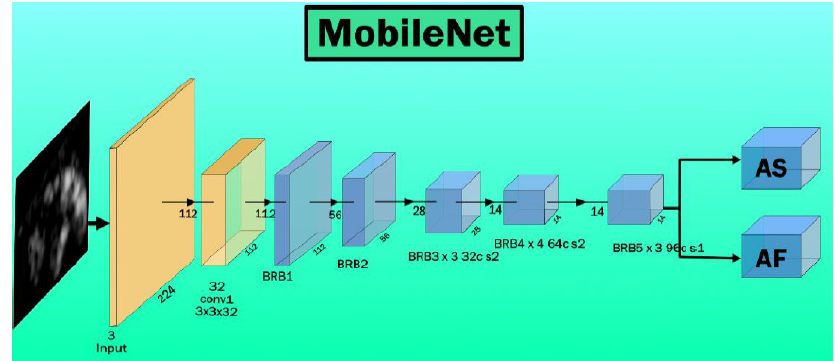
Figure A6. MobileNet Architecture, BRB: bottleneck and residual blocks [44].